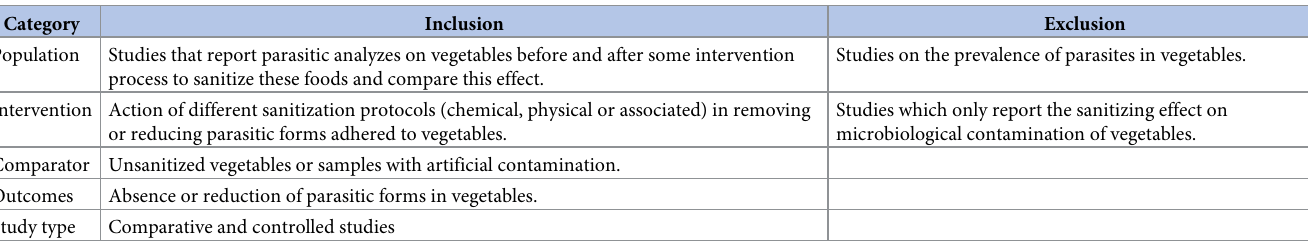
Table 1. Eligibility